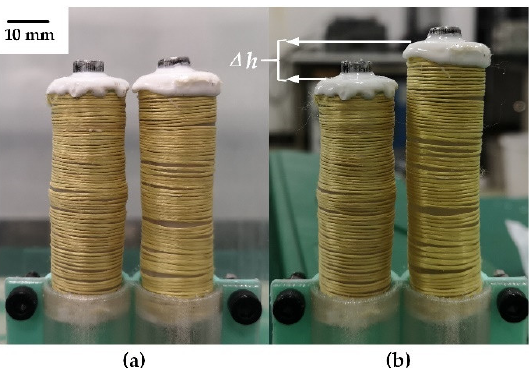
Figure 2. Theoretical and functional verification experiments: ( a ) original state and ( b ) state after displacement of Δh .